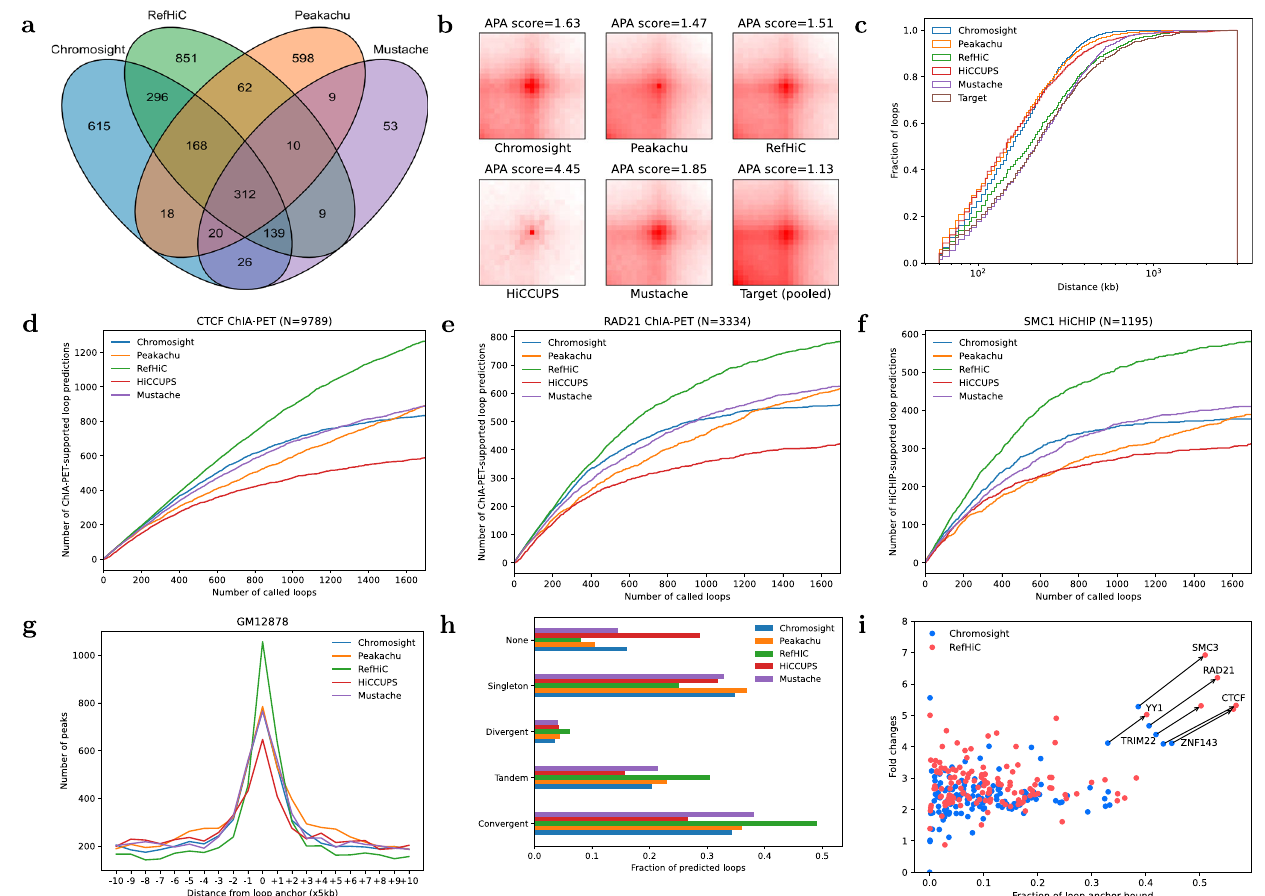
Fig. 2 | Comparison of RefHiC, Chromosight, Peakachu, HiCCUPS, and Mus- tache on GM12878 Hi-C data (500M valid read pairs). a Venn diagram of loops predictedbydifferenttools. b Aggregatepeakanalysispro fi lesfortarget(ChIA-PET andHiCHIPidenti fi ed)andannotatedloops. c Cumulativedistancedistributionsof predicted loops. RefHiC ’ s predicted loop distance distribution closely resembles that of ChIA-PET/HiCHIP-supported loops (target). d – f Number of ChIA-PET/ HiCHIP-supported loop predictions, among the top 1700 predictions made by RefHiC and other tools, for test chromosomes chr15, chr16, and chr17, compared againstCTCFChIA-PET( d ),RAD21ChIA-PET( e ),andSMC1HiCHIP( f ).RefHiC ’ sloop